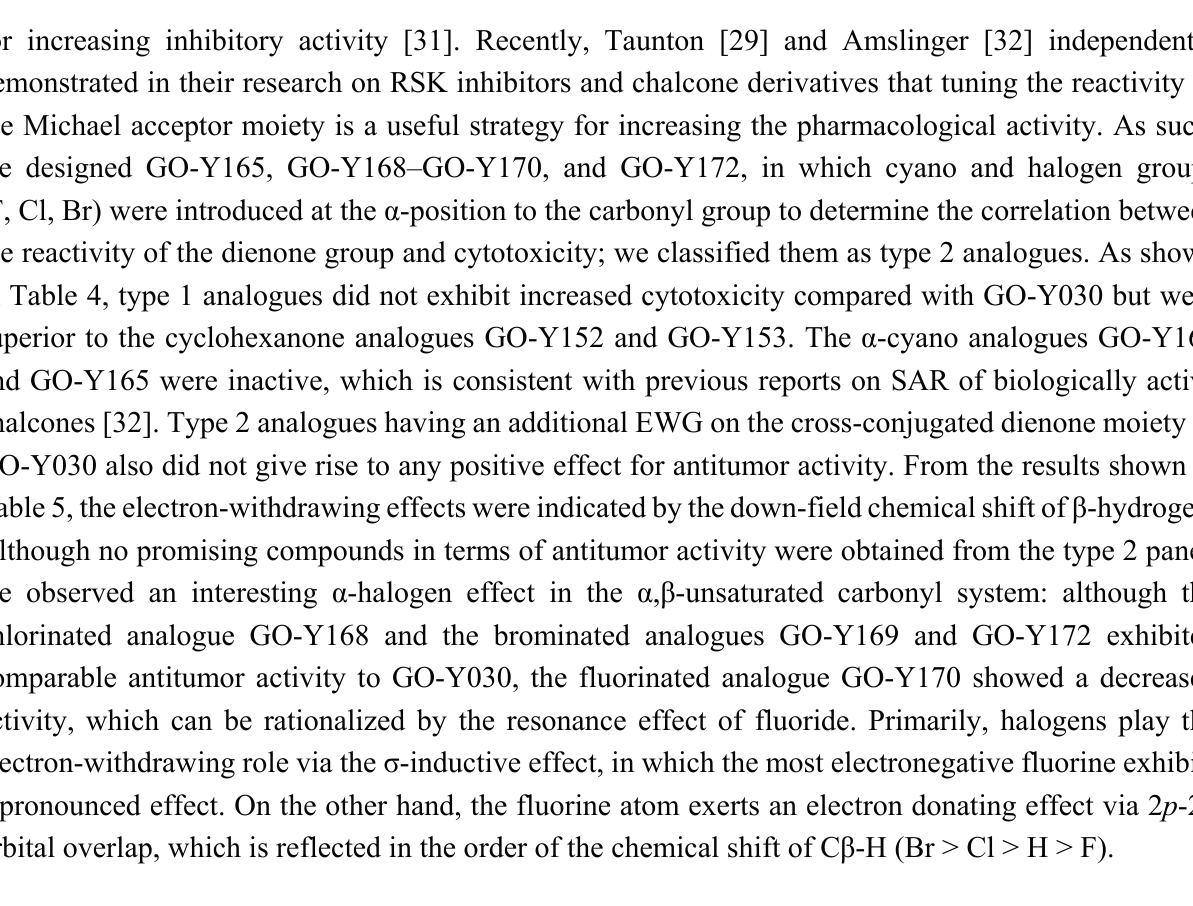
Table 4. SAR of the central tether moiety: introduction of electron-withdrawing group and amine.